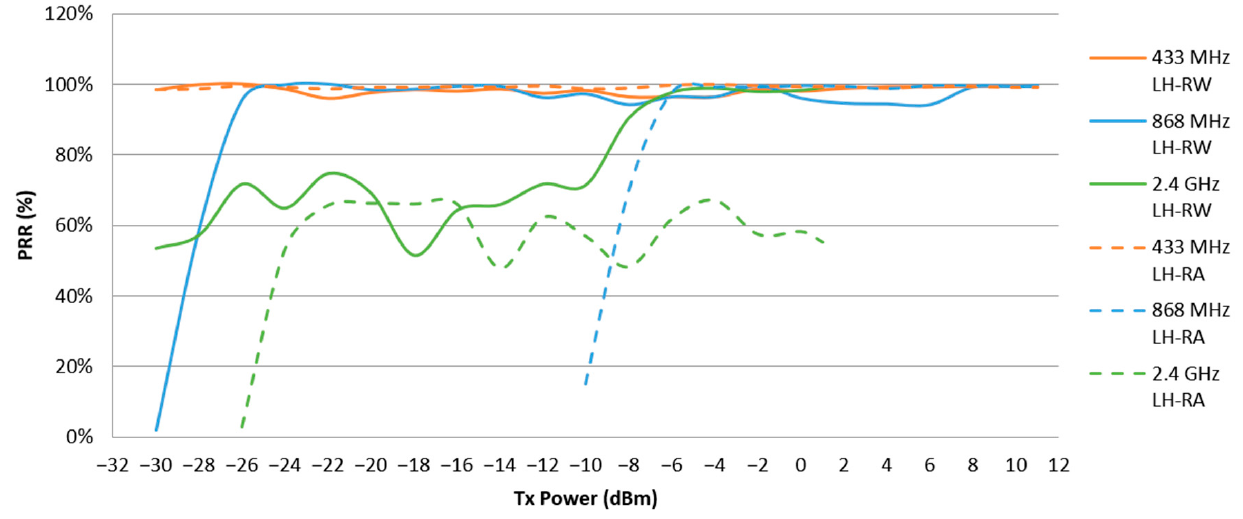
Figure 8. PRR in the sitting scenario.